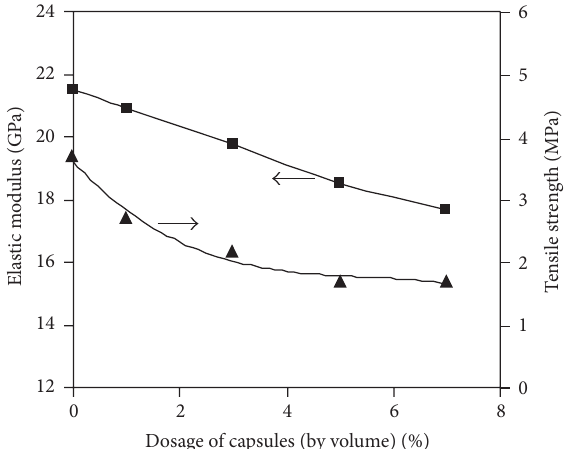
Figure 14: The elastic modulus and tensile strength of the samples with different amount of